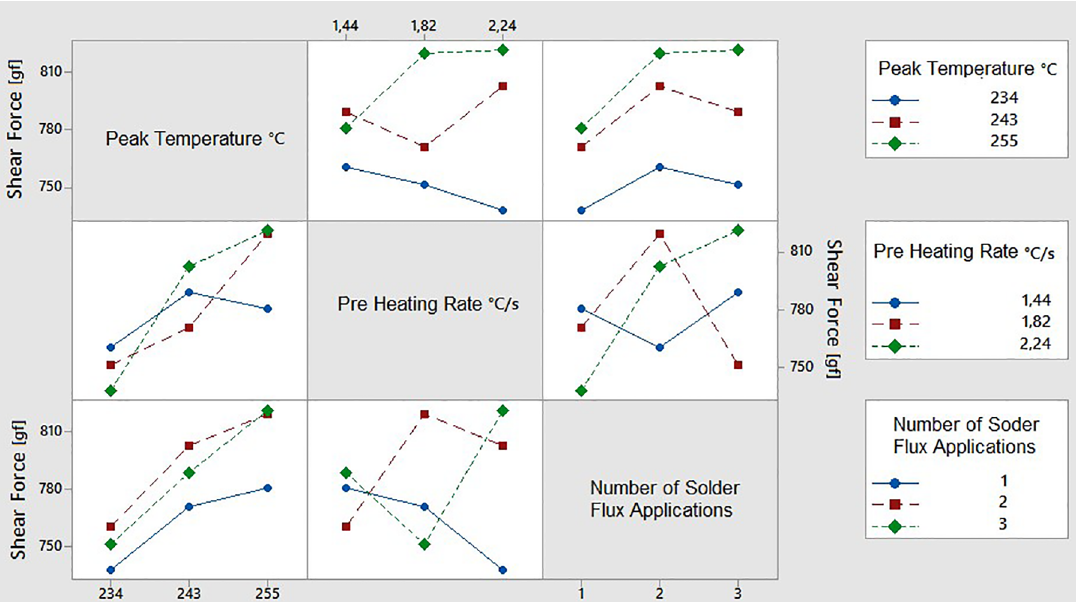
Figure 4. Shear stress